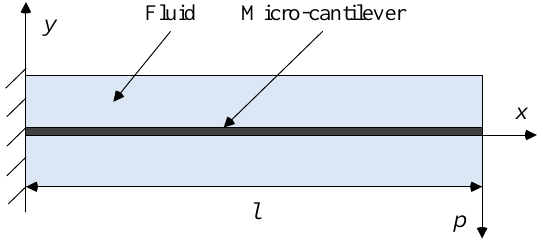
Figure 4. The cross section of the micro-cantilever in a fluid.